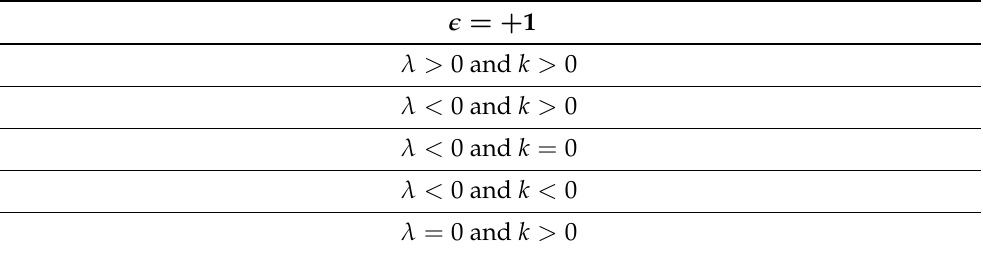
Table 3. Possible independent solutions for (cid:101) = + 1.